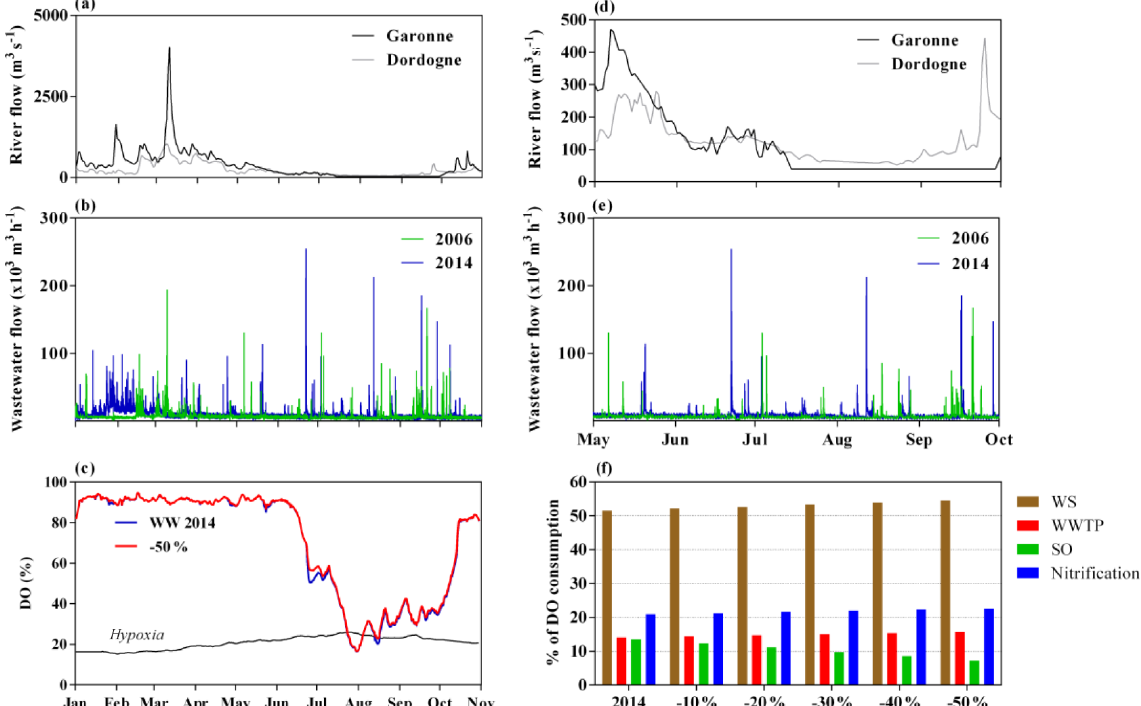
Figure 2. Time series of Garonne River (black) and Dordogne River (grey) flow of the reference simulation ( a, d ; m 3 s − 1 ), and wastewater discharges (WWTP ± SO) for 2006 (green) and 2014 (blue) ( b, e ; m 3 s − 1 ): panels (a) and (b) present the whole simulation period from January to October, and panels (d) and (e) present a zoomed view from May to October. Comparison of simulated DO min evolution (over tidal cycle in % saturation) in Bordeaux with urban effluents of 2014 (blue) and with a 50% reduction in SO (red) (c) . The contribution to DO consumption (%) of degradation of watershed organic matter (brown), WWTP (red), SO (green) and nitrification (blue) in Bordeaux (f) . For nitrification processes, ammonium comes from watershed and